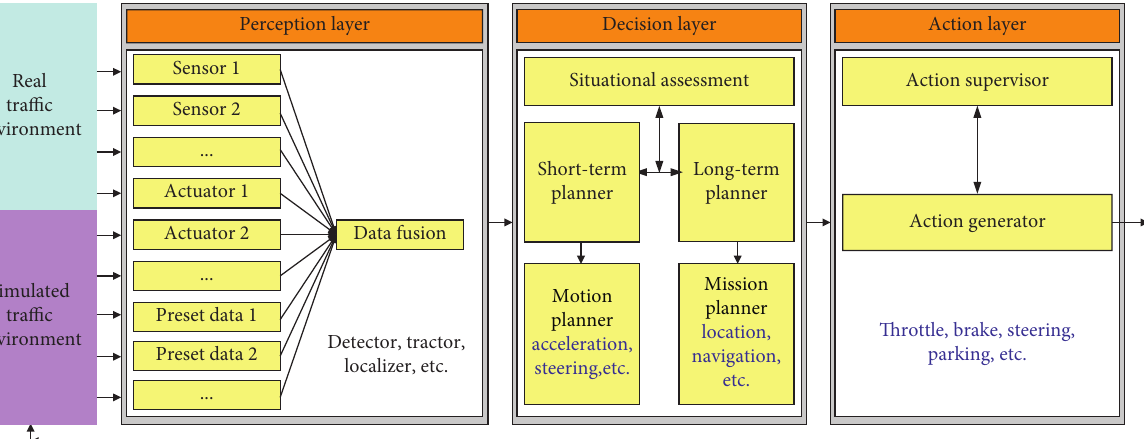
Figure 1: A typical autonomous vehicle system